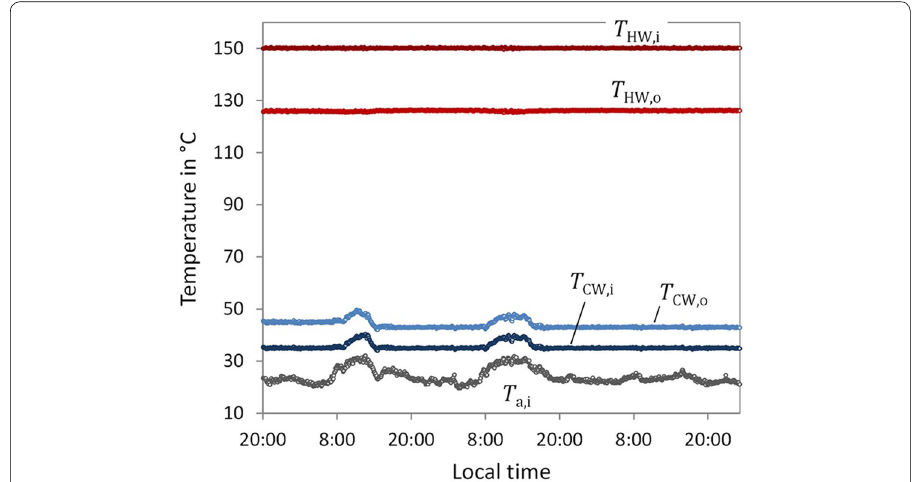
Fig. 8 Plant data for 48 h operation—temperatures heat supply and removal